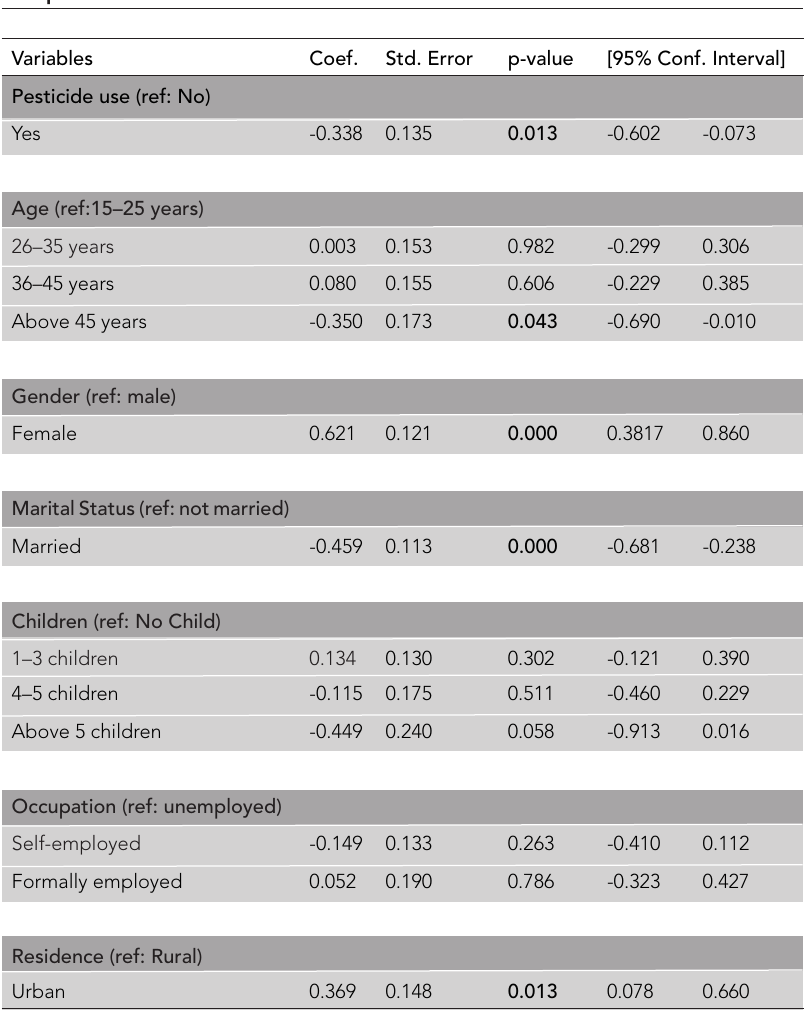
Table 1. Bivariate OLS regression model of the relationship between knowledge of health effects of Endocrine disruptors and pesticide use, and compositional and contextual